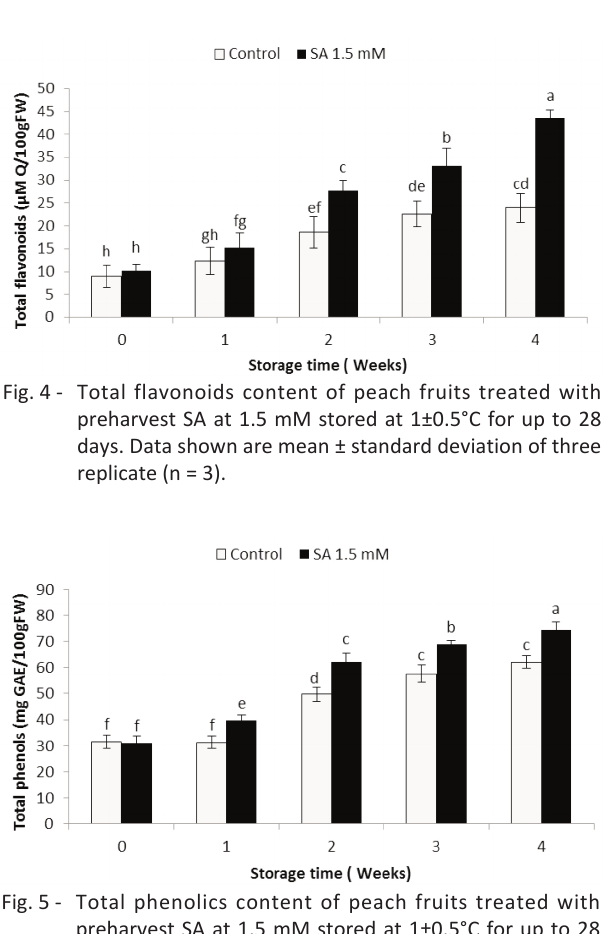
Fig. 5 - Total phenolics content of peach fruits treated with preharvest SA at 1.5 mM stored at 1±0.5°C for up to 28 days. Data shown are mean ± standard deviation of three replicate (n =